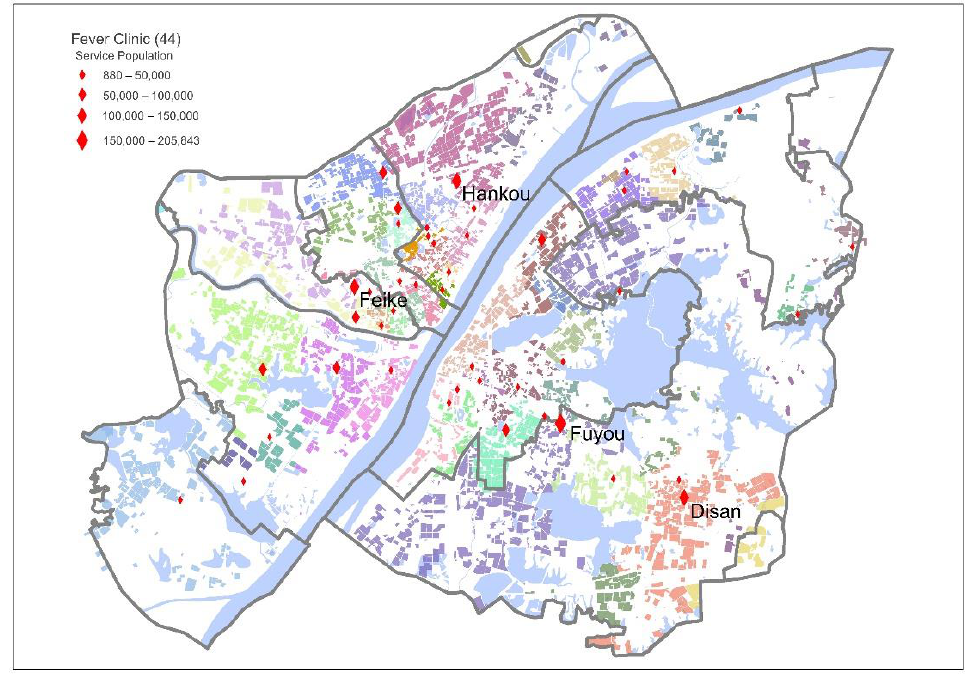
Figure 7. Service areas (in different colors) and service population (in different sizes) of the fever clinics. fever clinics.